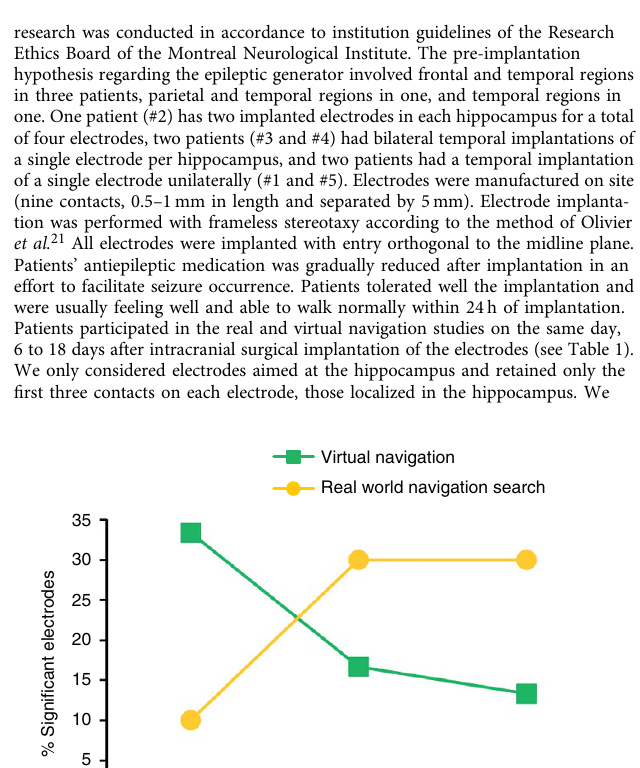
Table 3 | Number of electrodes showing statistically significant LFOs. Number of significant electrodes for the specified comparison ( P o 0.01) Experimental Control Total no. of electrodes for each patient No. of significant electrodes for that comparison